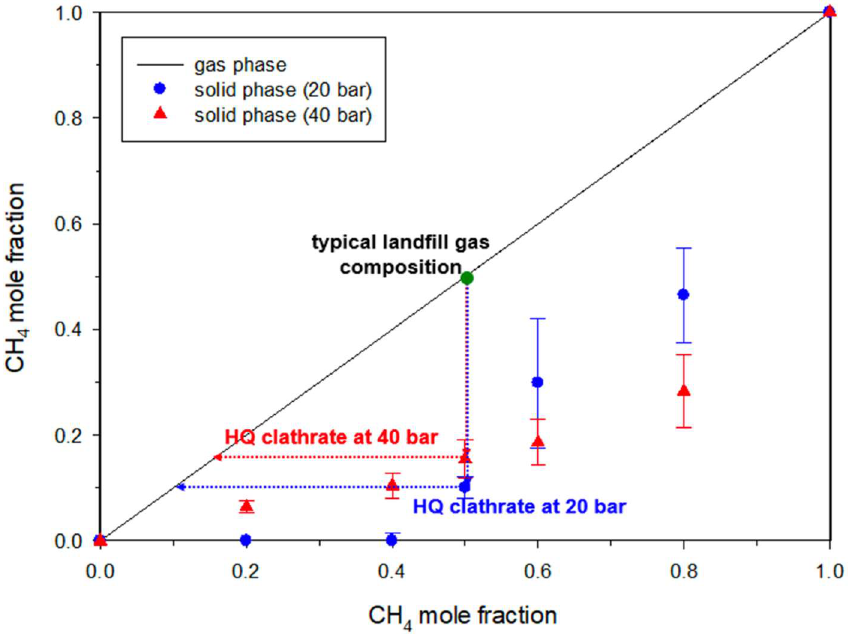
Figure 6. Analyzed CH 4 compositions in the solid clathrate phase after reactions with binary (CH 4 + CO 2 ) gas mixtures of various compositions. Blue and red dotted lines illustrate CO 2 concentration after reaction of HQ clathrate with an equimolar gas mixture (potential landfill gas) at 20 and 40 bar, respectively.